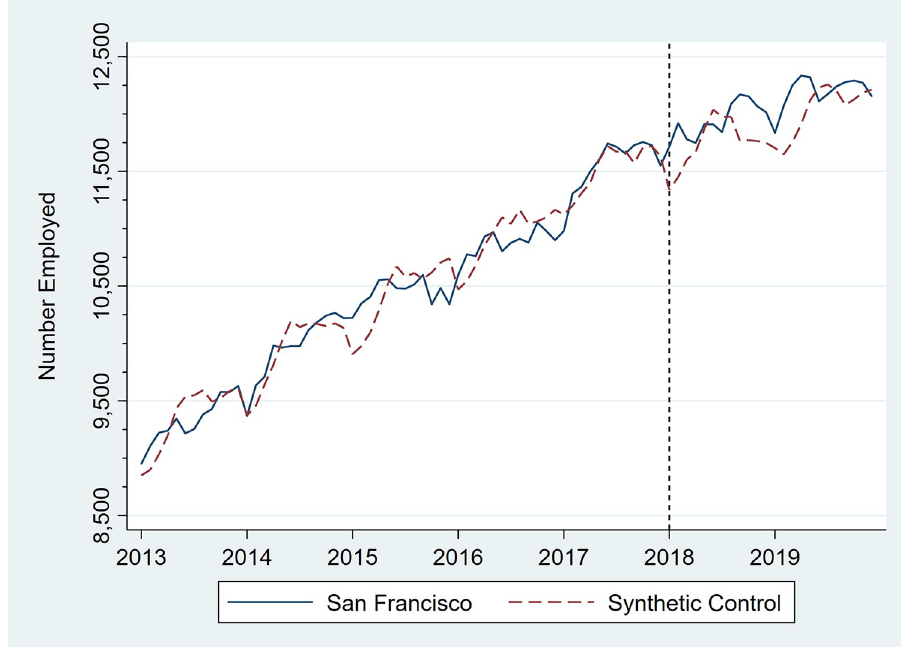
Fig 5. Number of persons employed in limited-service restaurants, San Francisco, CA, and its synthetic control, monthly, January 2013 through December 2019.